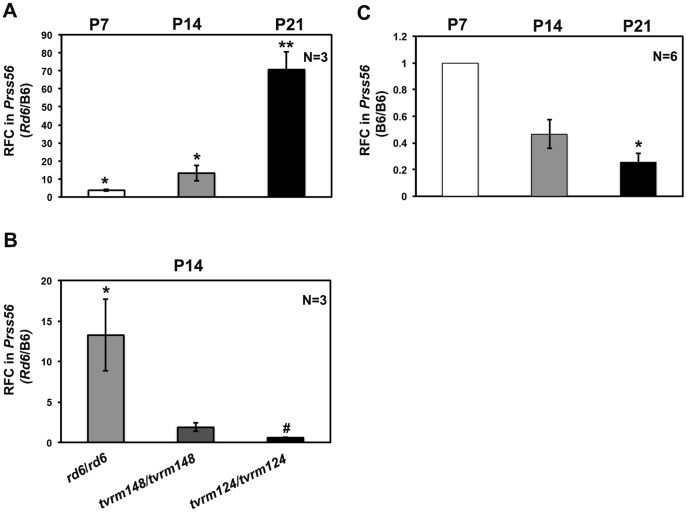
Independent qRT-PCR validation of genes that were differentially expressed in Mfrprd6/Mfrprd6 mutants by array analysis.The upregulated gene Prss56 was evaluated at three different time points. (A) At P7, there was a 3.5-fold increase in Prss56 transcript and it increased to 14-fold by P14, followed by a further 70-fold increase in Prss56 transcript in Mfrprd6/Mfrprd6 mutants at P21. (B) At P14, when compared to the Mfrprd6/Mfrprd6 mutant, in Tulp1tvrm124/Tulp1tvrm124 mutants, there was no significant change in Prss56 transcript, whereas in Rpe65tvrm148/Rpe65tvrm148 mutants, there was a significant decrease. (C) Wildtype levels of Prss56 transcript revealed a significant decrease between P7 and P21 timpoints, whereas the decrease from P7 to P14 was not statistically significant. Data are expressed as relative fold change (RFC) in the Prss56 transcript after normalizing to the wild-type control (B6). RFC was calculated by the ΔΔCT method using β-actin as an internal calibrator. Each value represents RFC ± S.E.M. * P<0.05 and ** P<0.001 relative to controls. N = 3 per group.